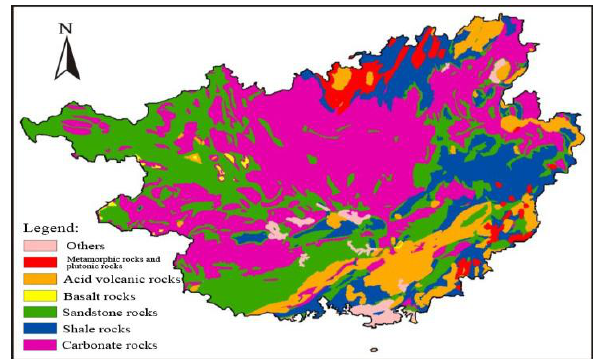
Figure 5. The classification result of lithology in Guangxi (Tao,